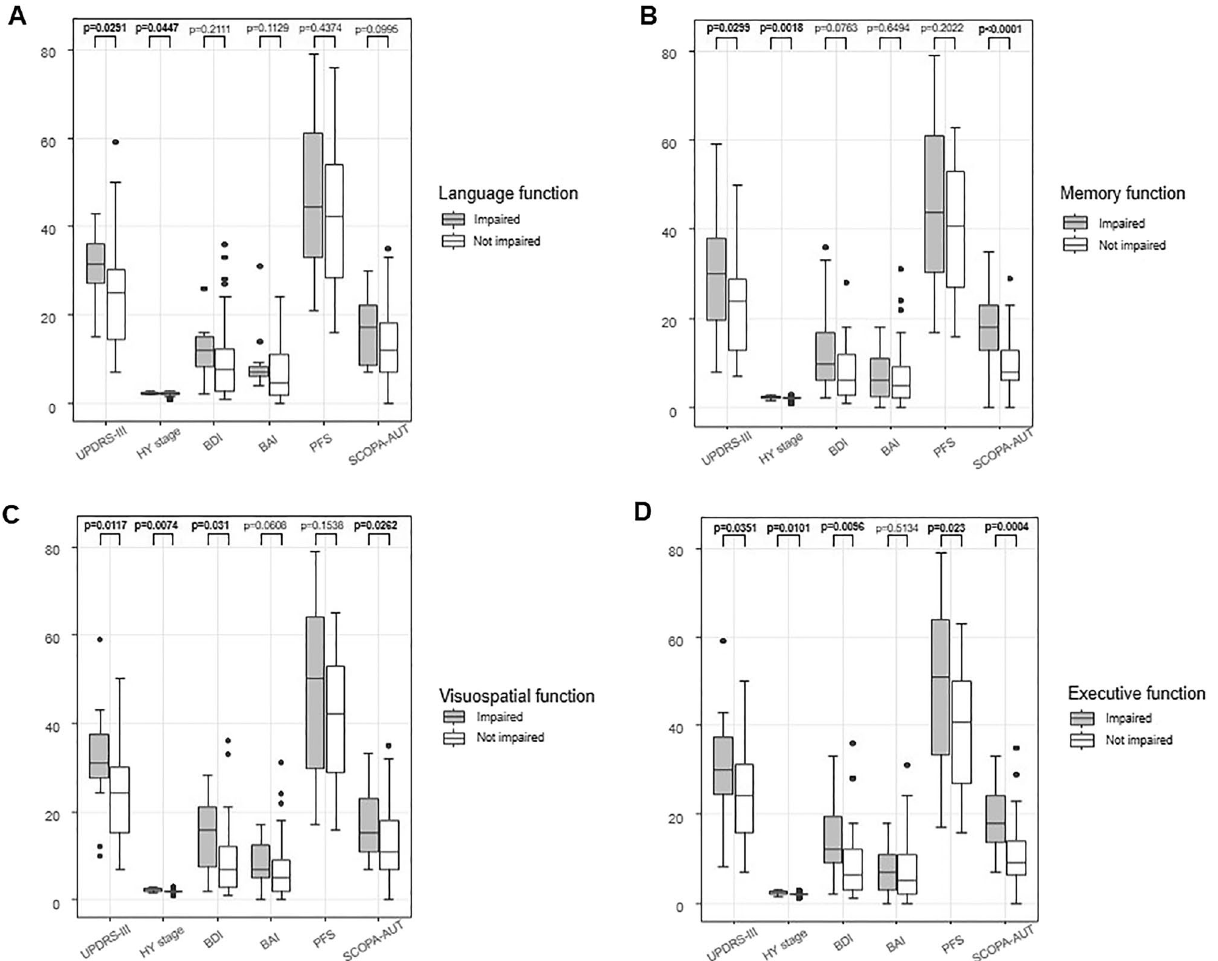
Figure 1. Comparison of motor or non-motor symptoms between de novo PD patients with and without impairment in each cognitive domain. Comparison of motor or non-motor symptoms between patients with de novo PD with and without language impairment ( A ). Comparison of motor or non-motor symptoms between those with and without memory impairment ( B ). Comparison of motor or non-motor symptoms between those with and without visuospatial impairment ( C ). Comparison of motor or non-motor symptoms between those with and without executive impairment ( D ). Y-axes indicate scores for each variable including UPDRS-III, HY stage, BDI, BAI, PFS, or SCOPA-AUT in the x-axes, thereby the units of the y-axes are dependent on the clinical variables in the x-axes. Abbreviations: PD, Parkinson’s disease; UPDRS-III, Unified Parkinson’s disease rating scale-part 3; HY stage, Hoehn and Yahr stage; BDI, Beck depression inventory; BAI, Beck anxiety inventory; PFS, Parkinson’s disease fatigue scale; SCOPA-AUT, the Scale for Outcomes in Parkinson’s disease-Autonomic